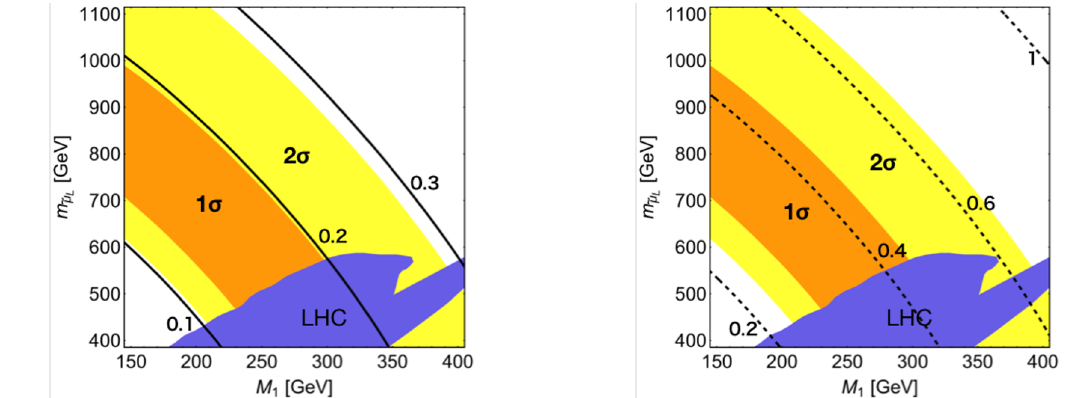
Figure 1 . The muon g − 2 anomaly can be addressed by the SUSY contribution at the 1 σ ( 2 σ ) level in the orange (yellow) shaded region. The left and right panels correspond to the U(1) H models with S 3 and S 4 , respectively. In both panels, we assume only the left-handed sleptons and electroweakinos (bino, wino and higgsinos) are light and the right-handed sleptons, all squarks, the gluino, and the heavy Higgs bosons are decoupled. We take tan β = 50 and µ = M 2 = 2 M 1 . To estimate the SUSY contribution to the muon g − 2 , the public code susy_flavor_v2.5 [53–55] is used. The result is consistent with the one-loop calculation presented in ref. [13]. The purple shaded region is excluded by searches for slepton pair production at the Large Hadron Collider (LHC) [71–74], as discussed in refs. [75, 76]. The black solid lines in the left panel correspond to the current electron EDM bound, | d e | = 1 . 1 × 10 − 29 e cm , by using µ = | µ | (1+ i κλ 6 ) where λ = 0 . 2 and κ = 0 . 1 , 0 . 2 , 0 . 3 from the left to the right, respectively. The black dashed lines in the right panel correspond to the future reach of electron EDM measurements, | d e | = 10 − 30 e cm , by using µ = | µ | (1 + i κ λ 8 ) where λ = 0 . 2 and κ = 0 . 2 , 0 . 4 , 0 . 6 , 1 from the left to the right,